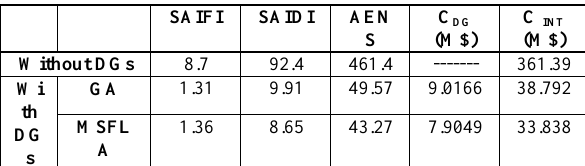
Table 2. Comparison of outputs before and after installation of dgs